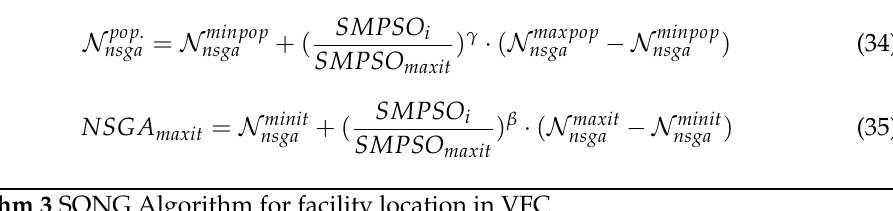
Algorithm 3 SONG Algorithm for facility location in